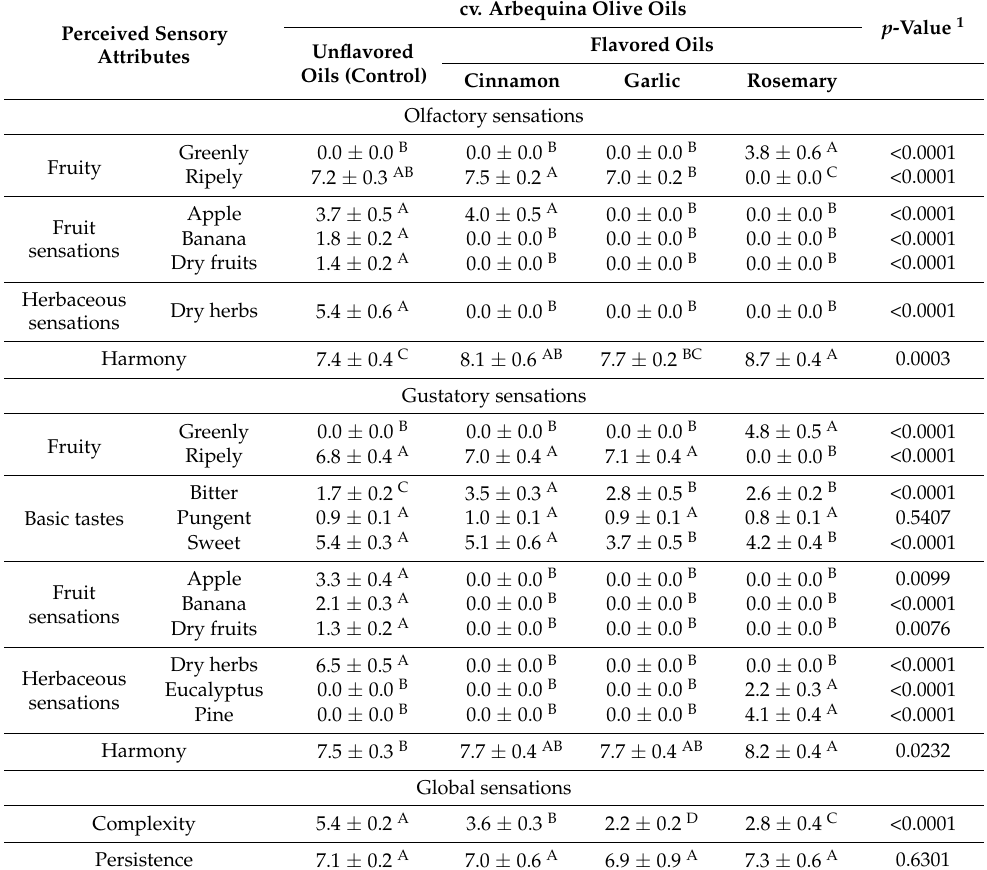
Table 2. Intensities of olfactory, gustatory and global sensations (mean ± standard deviation, for each unflavored or flavored oil: n = 8 olive oil bottles × 2 samples × 8 panelists) perceived by the trained sensory